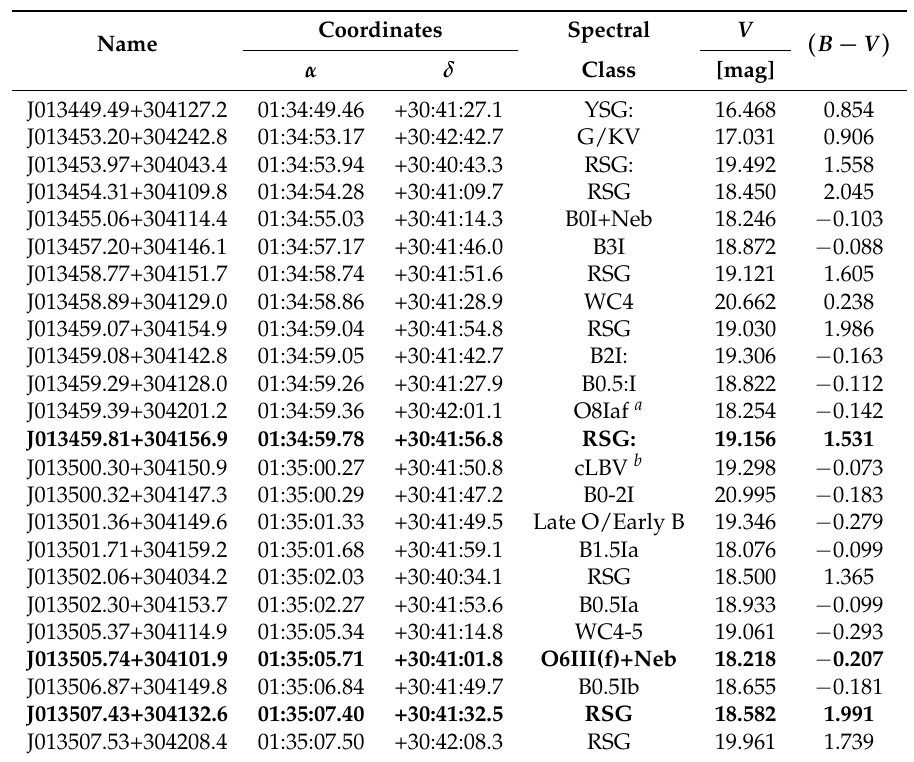
Table 1. Stars in the vicinity of GR290 spectrally classified by Massey et al. [16] (and references therein). Names and coordinates are given according to Massey et al. [15]. The three stars also included in Table 2 are marked by